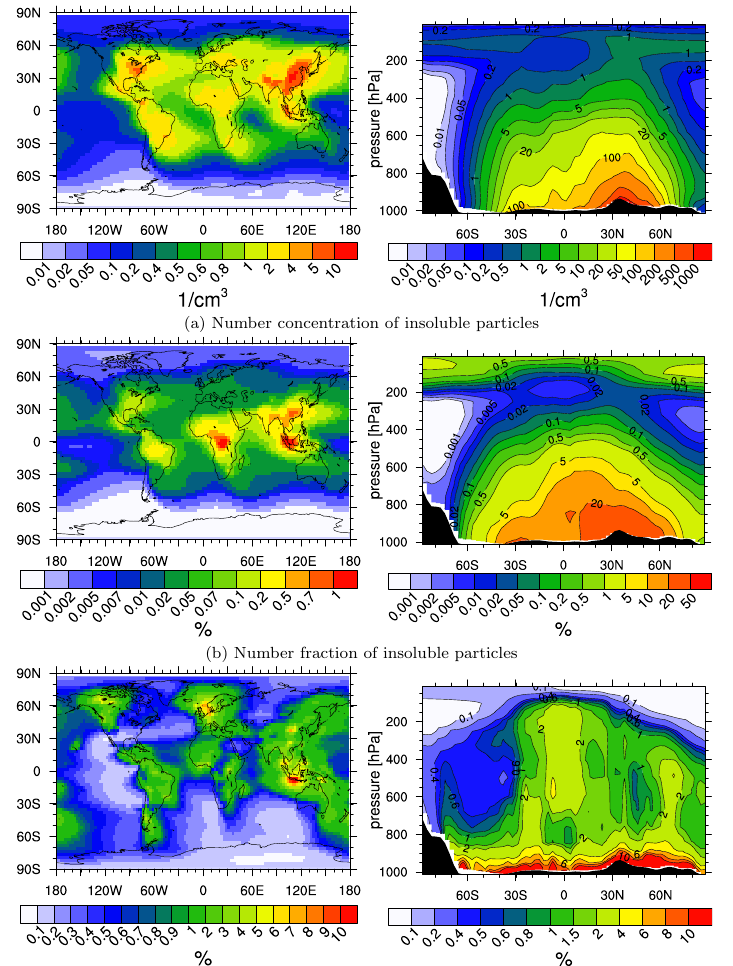
Figure 1: Annual means of the horizontal global distribution at 300 hPa (left) Fig. 16. Annual means of the horizontal global distribution at 300hPa (left) and zonal mean vertical distribution (right) of (a) the number and zonal mean vertical distribution (right) of (a) the number concentration of concentration of insoluble particles, (b) the number fraction of insoluble particles, and (c) the contribution of externally mixed BC and dust atmospheric potential IN, (b) the number fraction of potential IN, and (c) the particles to their total fraction of externally mixed potential IN to the number of IN.